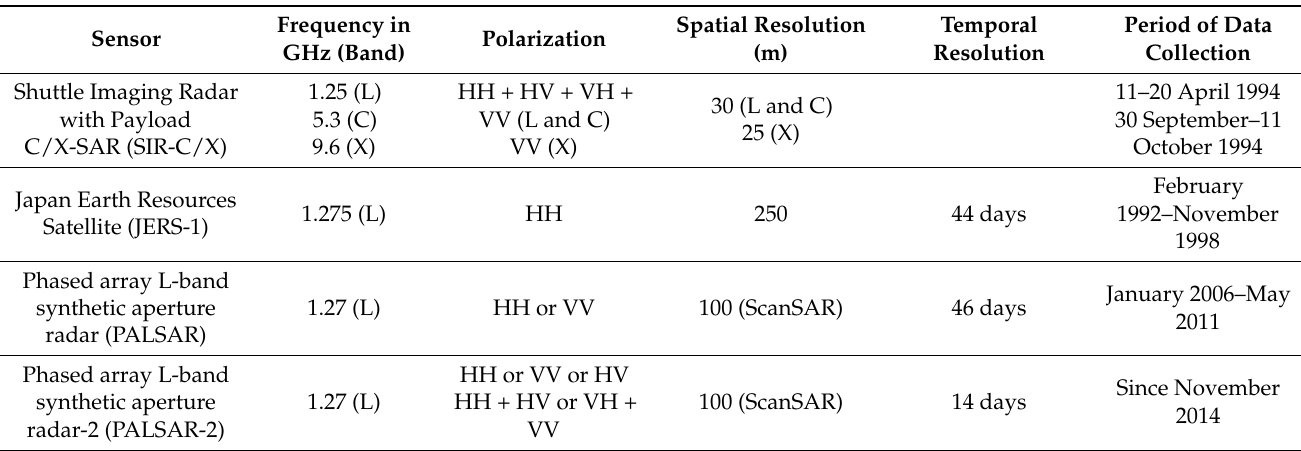
Table 1. Main characteristics of SAR missions used in InSAR mode for SWS estimates. The first column gives the name of the space mission. The second column is the frequency of operation with the frequency band in brackets. The third and fourth columns provide the spatial and temporal resolutions of the data. The fifth column provides the period of data